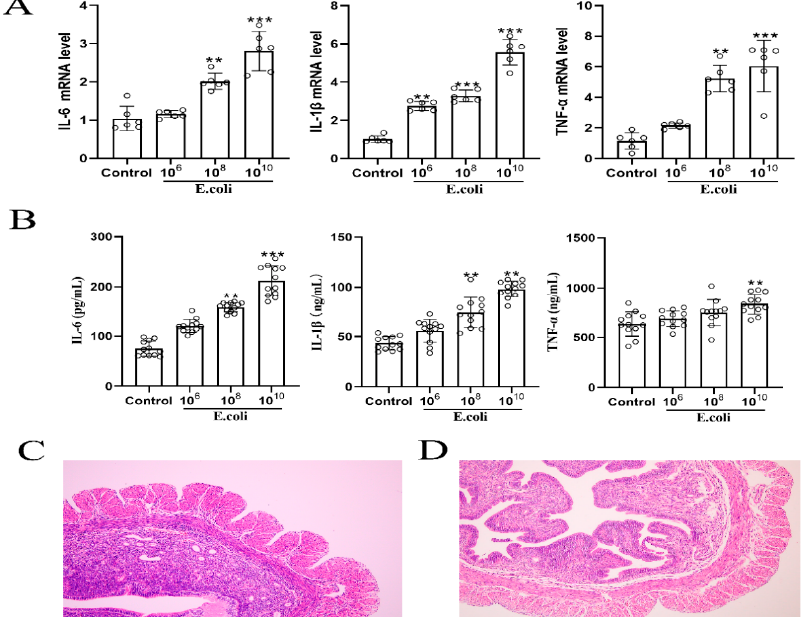
Figure 1. Infusion of Escherichia coli to establish a mouse model of endometritis. ( A , B ), Effects of different concentrations of Escherichia coli on mRNA and protein expression of IL-6, IL-1 β and TNF α . **, p < 0.01, ***, p < 0.001, indicates a significant difference compared with the control group. Section of uterine tissue from healthy ( C ) and endometritis ( D ) mice.